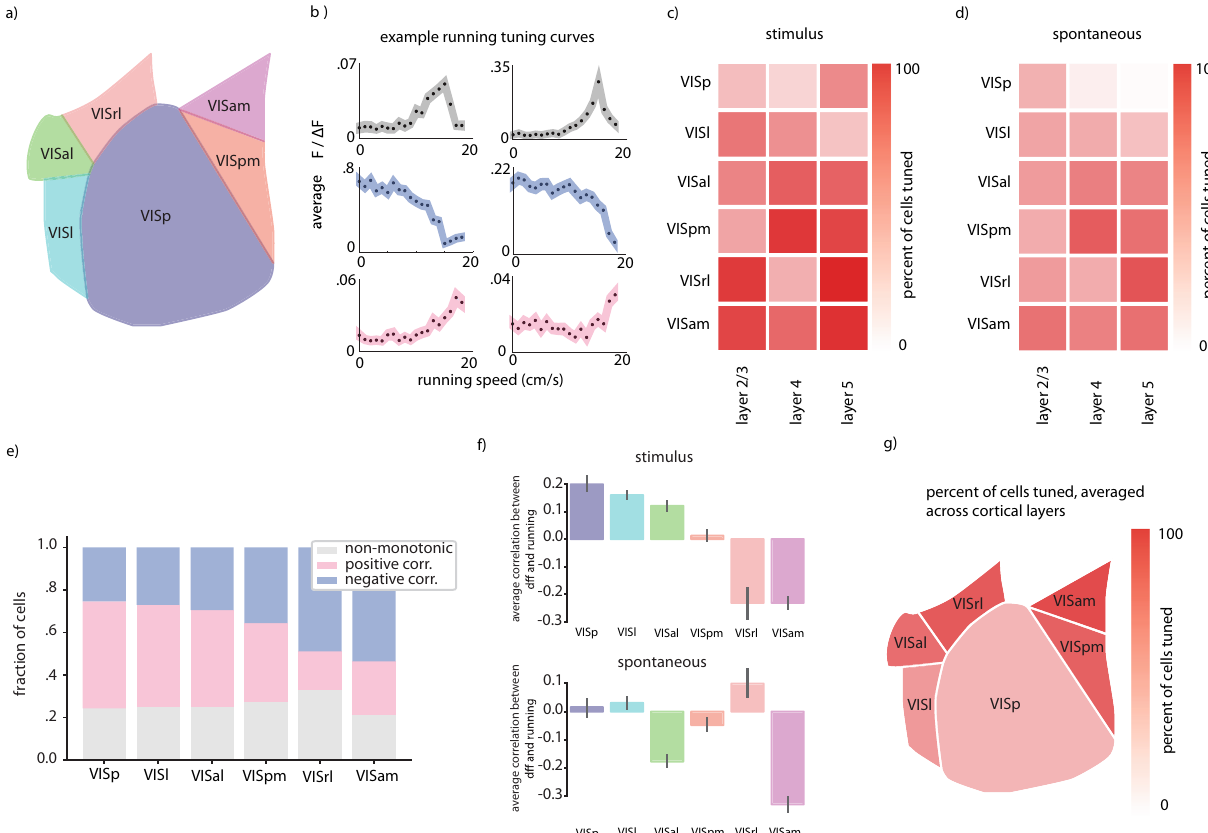
Fig. 1 Net correlation between neural activity and locomotion varies widely across different extrastriate regions. a Schematic of regions included in study. b Example non-monotonic, monotonically decreasing, and monotonically increasing tuning curves for running speed, top to bottom. Example cells are VISp layer 2/3. Error envelope represents standard error margin. c Overall fraction of neurons signi fi cantly tuned to running in each region and Cre-line, calculated during visual stimulus presentation. d Same as ( c ) except calculated in the absence of visual stimuli. e Fraction of cells displaying different tuning types to running speed across the visual regions we examined. f Average correlation coef fi cient between neural activity and running in each visual region, amongst neurons displaying signi fi cant ( p < 0.05) monotonic tuning to running. Error bars are 95% con fi dence interval for the mean estimate calculated via 1000 bootstraps. g Visualization of spatial distribution of overall tuning to running in the visual regions. Cell numbers included in each analysis can be found in Supplementary Fig. 1. Source data are provided as a Source Data fi